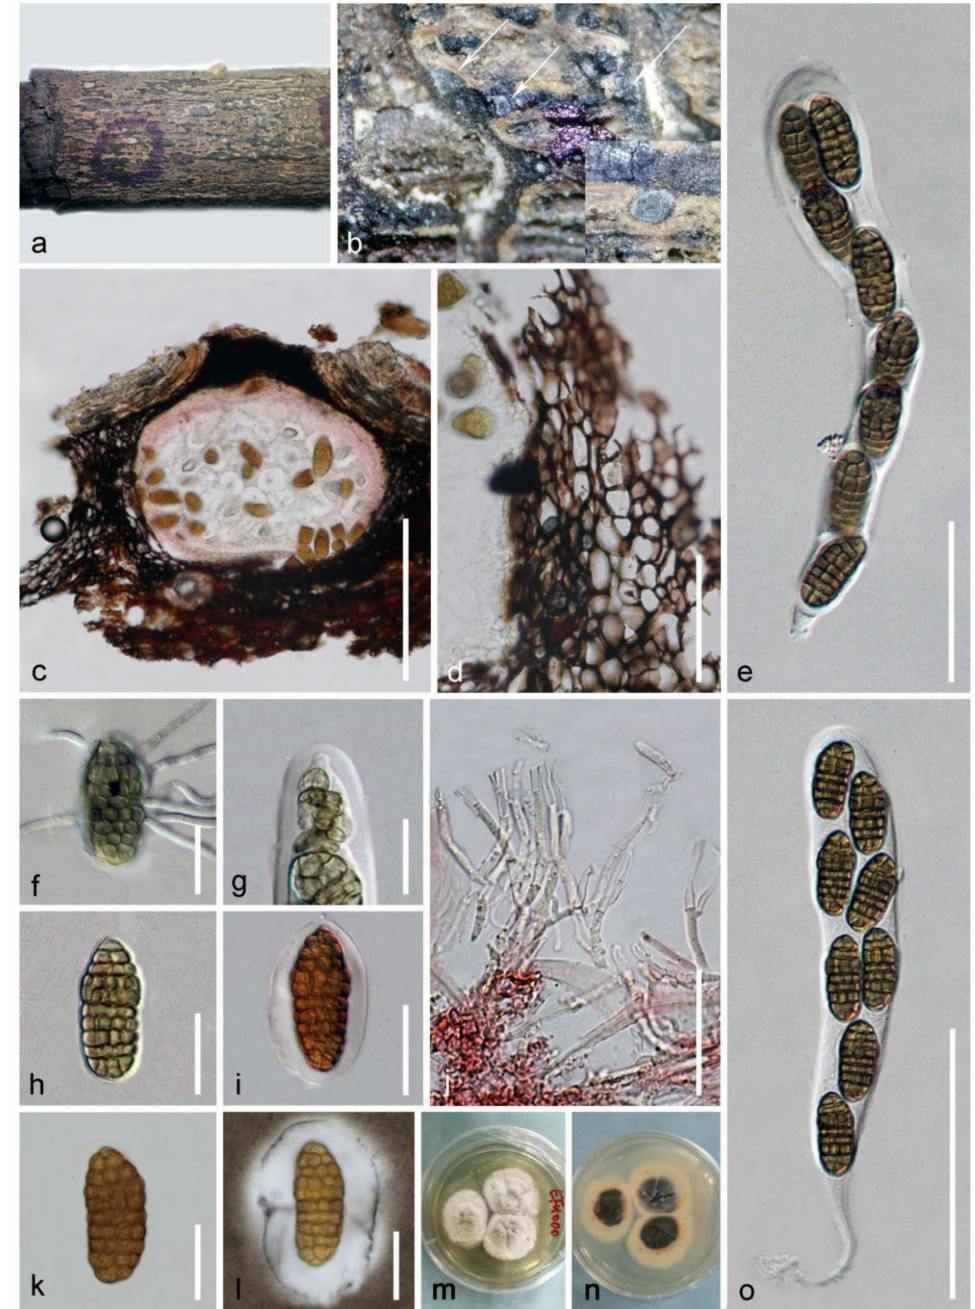
Figure 6. Mangifericomes hongheensis (HKAS 122188, holotype) ( a ) Ascomata on decayed branch of Mangifera indica ; ( b ) close-up of substrate; ( c ) section of ascoma stained by congo red; ( d ) peridium stained by congo red; ( e , o ) asci; ( f ) germinated ascospore; ( g ) ocular chamber; ( h ) brown ascospore; ( i , k ) ascospores stained with congo red; ( l ) ascospore stained with Indian ink; ( j ) pseudoparaphyses stained by congo red; ( m , n ) colonies on PDA. Scale bars: ( c ) = 150 µ m; ( e , o ) = 100 µ m; ( d ) = 50 µ m; ( j ) = 30 µ m; ( f – i , k , l ) = 20 µ